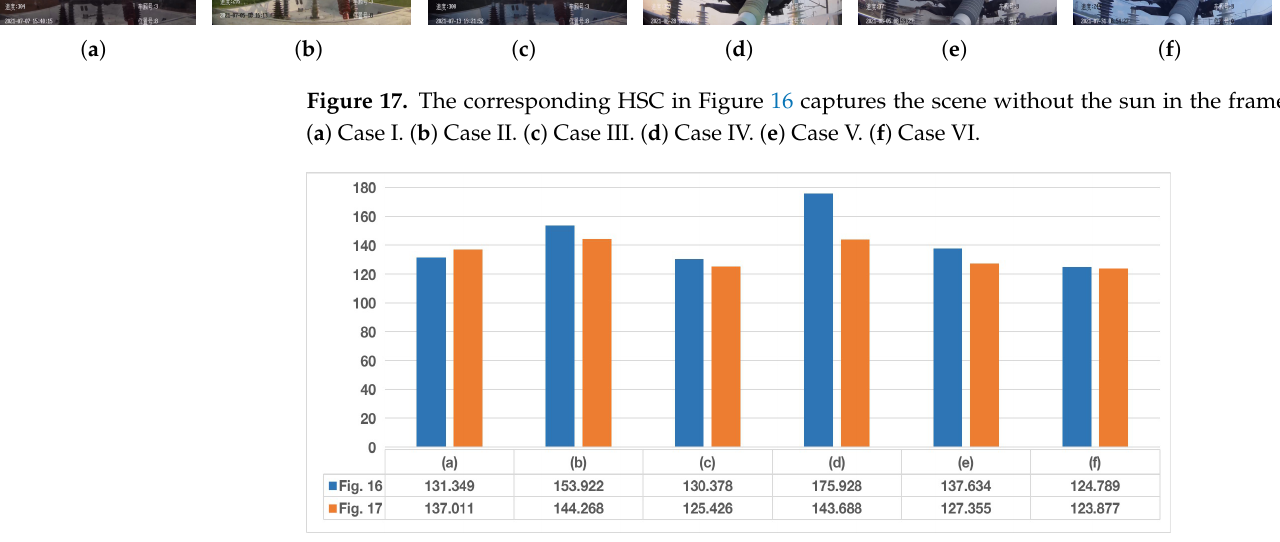
Figure 18. Average grayscale comparison. It can be found that the overall average grayscale of the image is not necessarily increased after the sun appears in the image captured by the HSC. However, when the sun affects the detection of pantographs, it will definitely cause an increase in the average grayscale of ROI. When the sun is not present the difference between the overall image and the average grayscale of the ROI is not significant, but once the sun affects the pantograph, it will definitely cause a large difference between the two. Using this unique difference, it is possible to determine whether the pantograph is detected as anomalous in the current image due to the sun. When the sun affects the pantograph detection, the average grayscale change of the overall image and ROI and the corresponding difference between the two average gray levels are shown in Figure